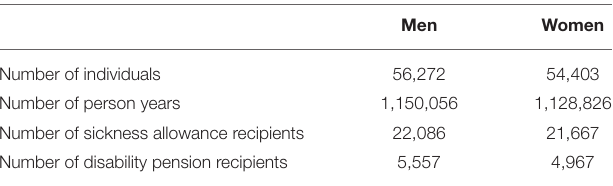
TABLE 1 | Number of individuals, person years, and sickness allowance and disability pension recipients by sex in the